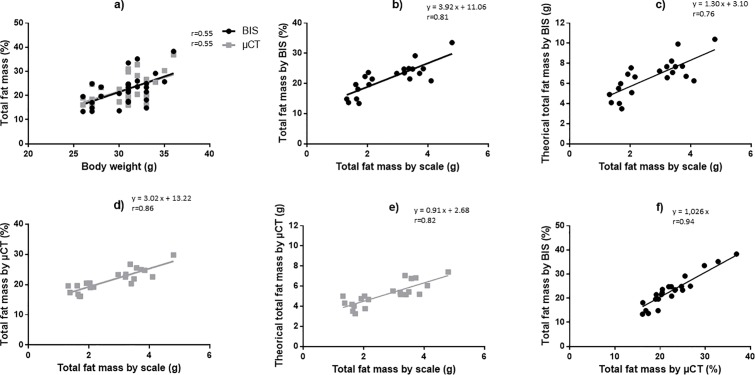
Relationships between the different methods of determination of total adipose tissue.Thirty mice (body weight ranging from 26 to 36g) were used. In each animal, the proportion of adipose tissue was measured with bioimpedance spectroscopy (BIS), micro-computed tomography (μCT) and by direct post-mortem tissue weigh as described in Material and Methods. Theoretical adipose tissue weight was calculated from body weight and BIS or μCT data. (a) Correlation between the body weight of animals and the proportion of total fat mass estimated by BIS and μCT. (b-e) Correlations between the weight of harvested adipose tissue and the proportion of fat mass estimated by BIS (b) or μCT (d) and between the weight of harvested adipose tissue and the theoretical calculated adipose tissue weight obtained by BIS (c) or μCT (e). (f) Correlation between total adipose tissue estimated by BIS and μCT. r is the Pearson correlation coefficient.